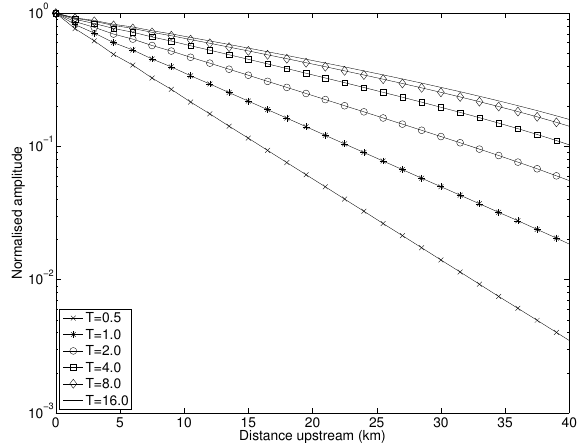
Figure 7. Normalised amplitude response to various periods (in days) of boundary forcing as a function of distance up- stream as calculated by the model. Model parameters used were A = 4 . 0 − 7 d − 1 kPa − 1 ,m = 1 ,n = 1 ,E = 3GPa ,ν = 0 . 45 and a value for the rate factor in the till to produce surface velocities of 1md − 1 . Note that amplitude is plotted on a log